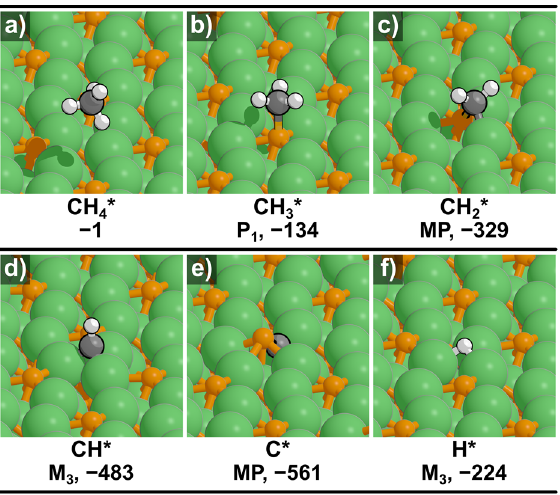
Figure 1. DFT-optimized structures for ( a – e ) CH x * (x = 0–4) and ( f ) H*. The binding energies (in kJ mol − 1 ) and adsorption modes are shown beneath each image (see Section 3 for more details). Table 1. DFT-predicted adsorbates binding energies Δ E ads (Equation (4); kJ mol − 1 ) and adsorption modes on Ni 2 P(001). Average bond distances of the carbon atom with surface atoms are shown in Å.